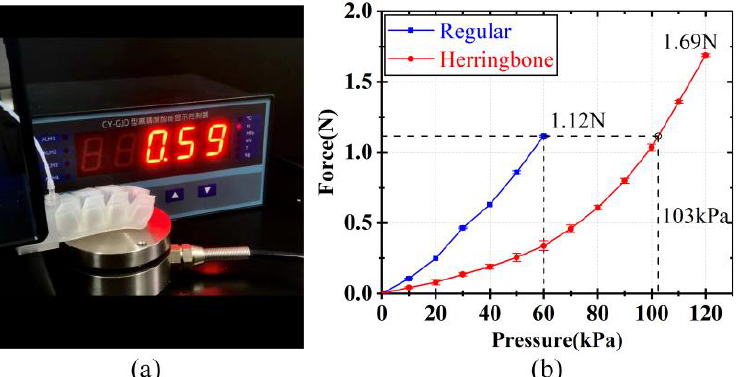
Figure 5. Blocking force test. ( a ) Experimental set up for the measurement of blocking force. ( b ) Blocking forces of actuators under different input pressures. Each test is repeated five times, and the error bars indicate the standard deviation of the measurements.